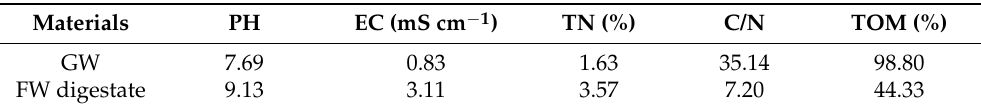
Table 1. The basic physicochemical characteristics of GW and FW digestate (TN and TOM correspond to total nitrogen and total organic